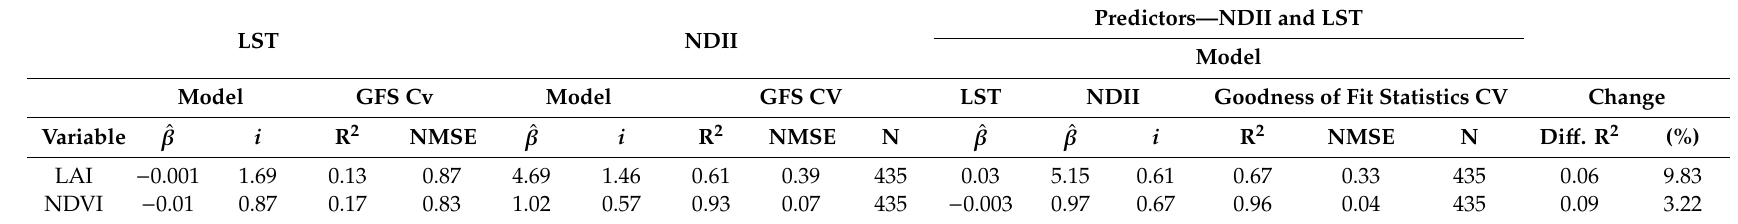
Table 4. CCR.LM coe ffi cients of estimates and goodness of fit statistics (at 95% confidence level) at annual scale with NDII and LST as predictors. Accounting for variations in LAI was improved by about 9.83% when LST and NDII were simultaneously inputted as predictors. Accounting for variations in NDVI improved by 3.22% when LST and NDII were simultaneously used as predictors.